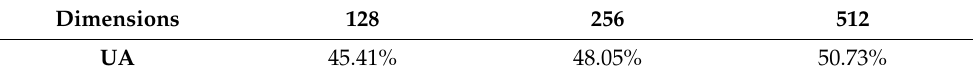
Figure 9. Reconstruction results on IEMOCAP with three autoencoders. The x -axis represents the time table and y -axis represents the frequency. ( a ) Input log Mel-spectrogram, ( b ) Simple AE, ( c ) DAE, ( d ) AAE. Table 4. Unweighted accuracy of classification with different feature dimensions in AAE.